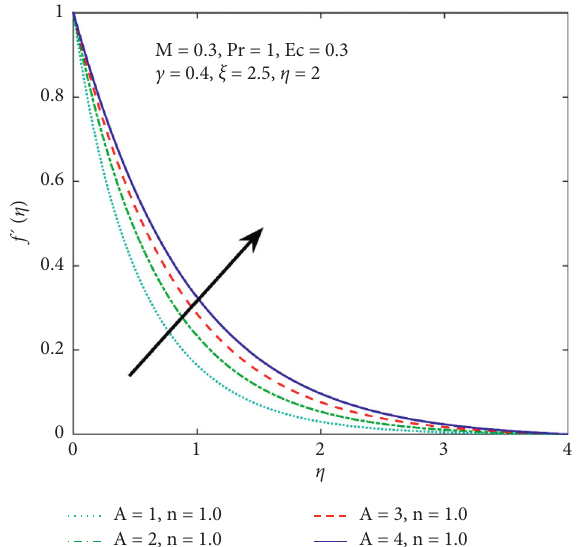
Figure 4: Velocity profile f ′ ( η ) for different values of material parameter ( A ) .